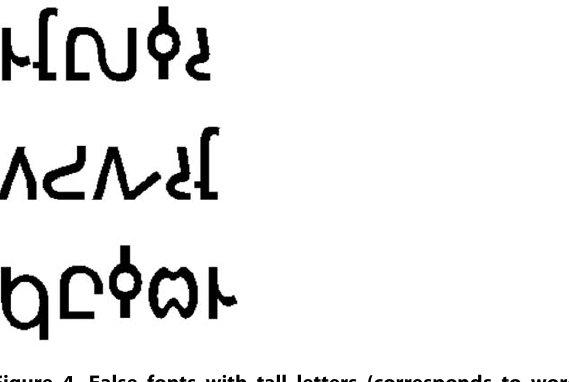
Figure 3. False fonts with no tall letters (corresponds to words ‘‘manor’’, ‘‘ounce’’ and ‘‘groom’’).